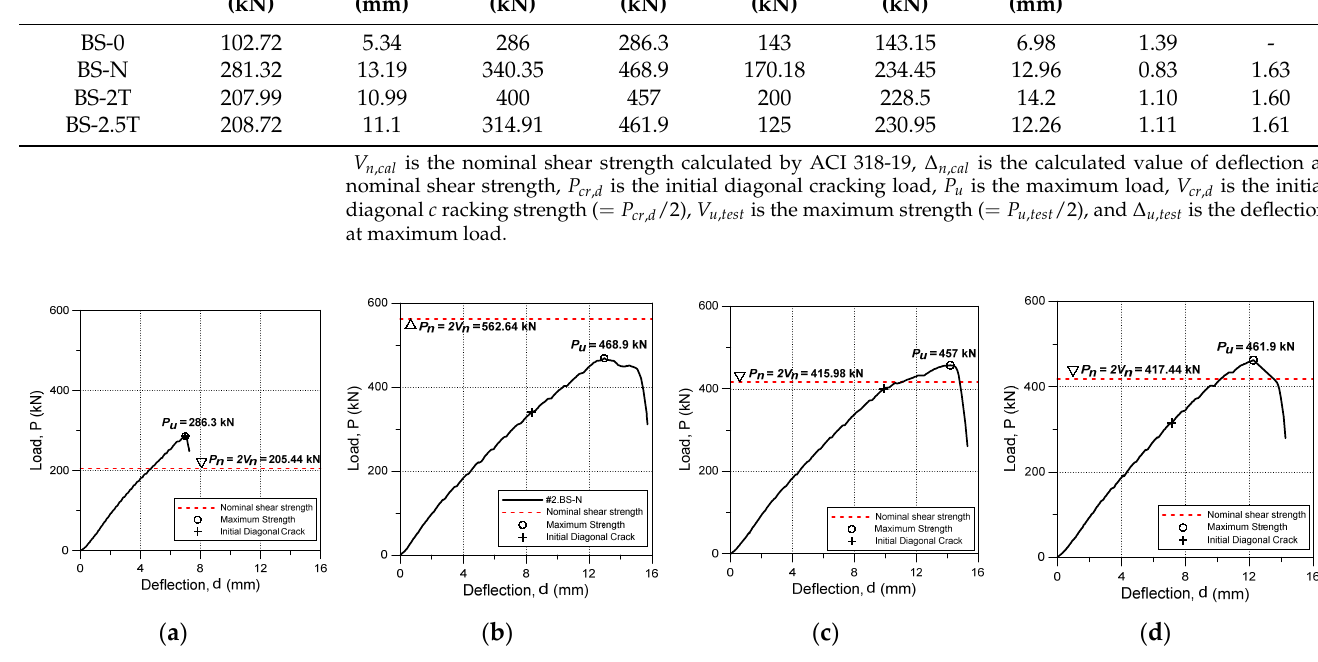
Figure 5. Load-deflection relationships. ( a ) BS-0. ( b ) BS-N. ( c ) BS-2T. ( d ) BS-2.5T. Table 4. Test results.